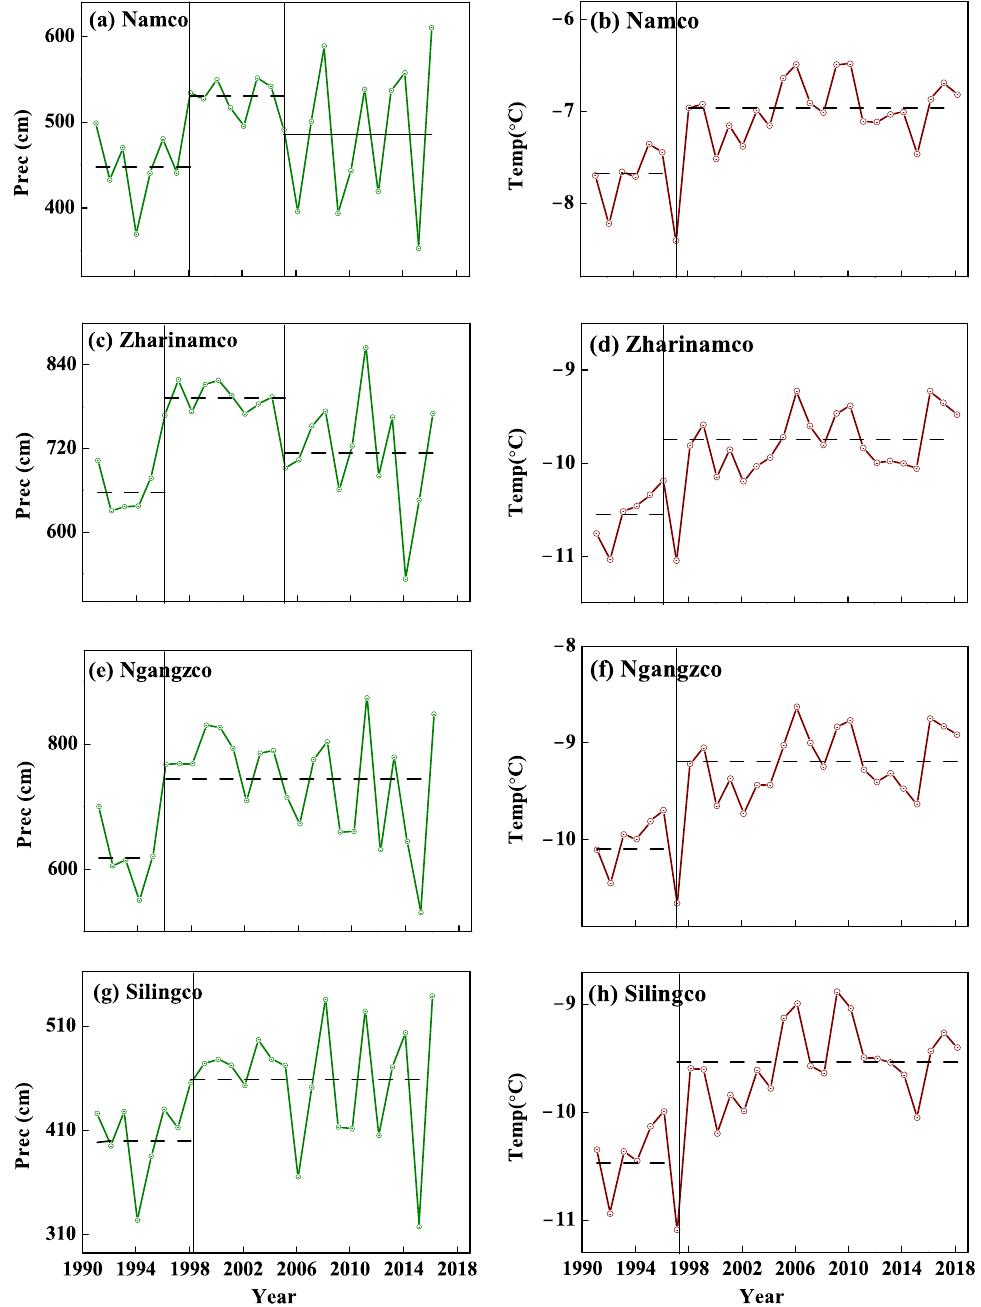
Figure 7. The significant regime shift in time series of precipitation (green line, left panel) and temperature (red line, right panel) over four lakes in the southern part of the Tibetan Plateau: vertical lines represent regime shift years and horizontal dash lines represent the mean value of each regime.